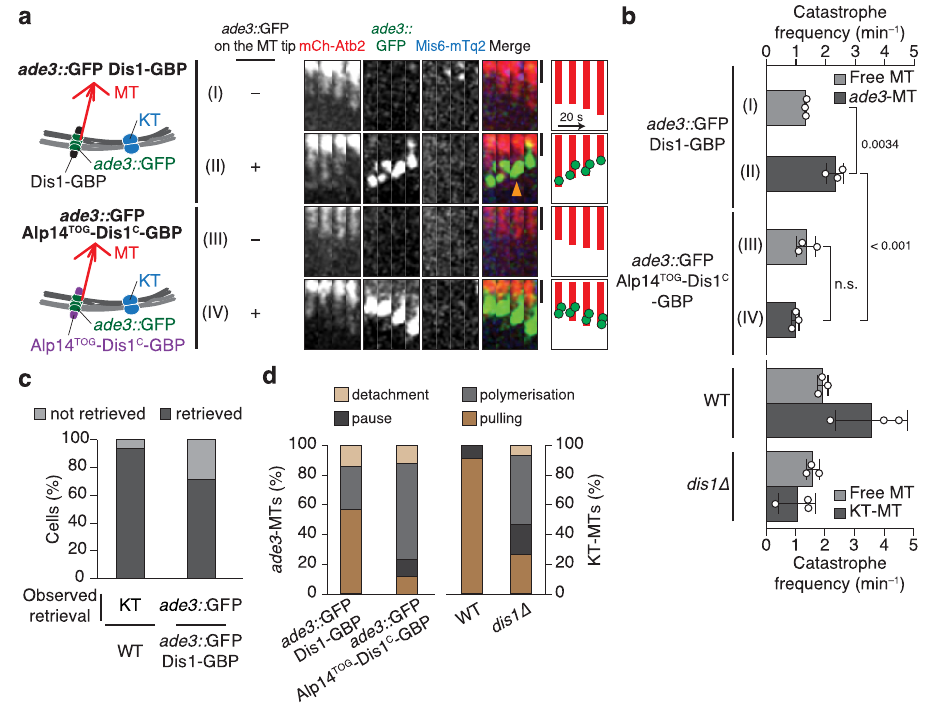
Fig. 4 End-on pulling of chromosomes by Dis1 oligomers without using kinetochores. a Schematic representation of the arti fi cial pulling of chromosomes without relying on kinetochores. Oligomers of Dis1-GBP or the chimaera Alp14 TOG -Dis1 C -GBP were arti fi cially clustered at the ade3 locus marked with GFP ( ade3:: GFP, green) on a chromosome arm. Time-lapse images of microtubules without (I and III) or with (II and IV) the ade3:: GFP locus were fi lmed at room temperature, and representative kymographs are shown. As a reference, the position of kinetochores (Mis6-mTq2, blue) is shown. The orange arrowhead indicates the start of the microtubule catastrophe. Scale bar, 1 µ m. b The catastrophe frequency was measured for each category in ( a ). Free MT, tips without kinetochores; ade3 -MT, tips with ade3:: GFP. The data for WT and Dis1 are reprised from previous data as references: the data for ‘ free MT ’ in WT are derived from Fig. 2c (ii and iii). Other data for WT and dis1 Δ are reprises of Fig. 2c (i, iv and v). Bullets indicate technical replicates ( n = 3 experiments); error bars, SD. The statistical signi fi cance of the difference was determined using one-way ANOVA followed by the Tukey – Kramer method. P values are shown; n.s., not signi fi cant. c Percentages of cells that accomplished retrieval of kinetochores to SPBs in WT meiocytes (WT, n = 16) or retrieval of the ade3:: GFP locus in ade3:: GFP Dis1-GBP meiocytes ( n = 28). χ 2 = 3.1 (two-sample test), P > 0.05. d Frequencies of 4 events (polymerisation, pulling, pause and detachment) observed in microtubule tips accompanied by the ade3:: GFP locus or kinetochores. n = 11 (WT), 15 ( dis1 Δ ), 14 ( ade3:: GFP Dis1-GBP), 17 ( ade3:: GFP Alp14 TOG -Dis1 C -GBP)